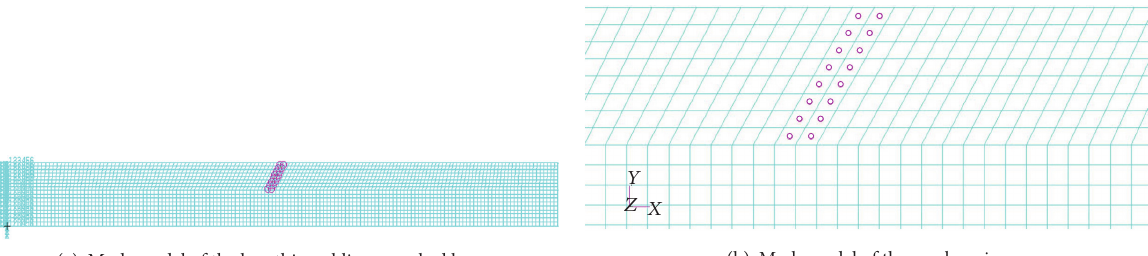
Figure 7: Mesh model of the breathing oblique